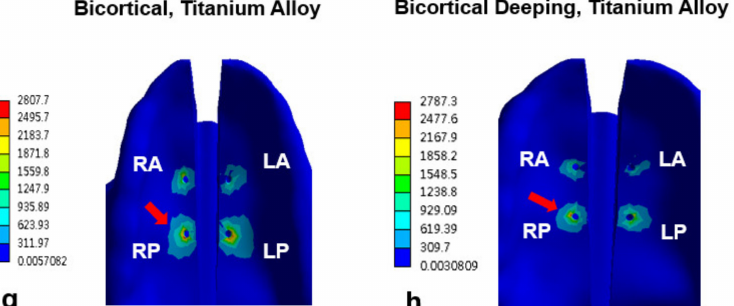
Figure 5. ( a – d ) Mean von Mises stress (MPa) of the peri-implant sites of stainless steel for the skull model with midpalatal suture for all 4 anchorage models. RA, right anterior; RP, right posterior; LA, left anterior; LP, left posterior. Red arrow represents the location of the peak stress in the FE model. ( e – h ) Mean von Mises stress (MPa) of the peri-implant sites of titanium alloy for the skull model with midpalatal suture for all 4 anchorage models. RA, right anterior; RP, right posterior; LA, left anterior; LP, left posterior. Red arrow represents the location of the peak stress in the FE model.